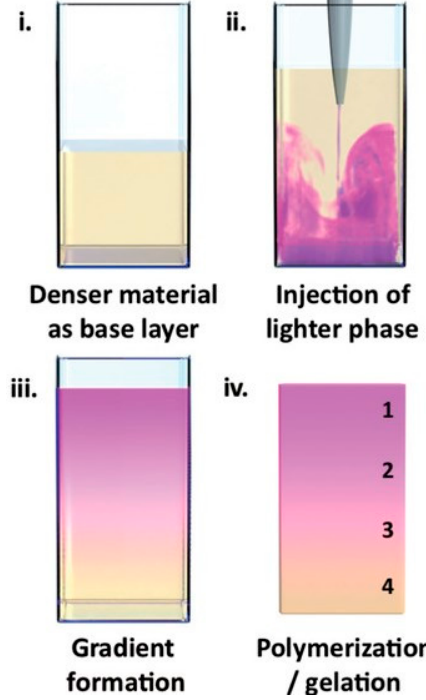
Figure 7. Buoyancy-driven gradient casting. Schematic showing the steps of gradient formation: ( i ) an ase layer (yellow) is added to a mold, ( ii ) the injection phase (purple) is introduced during a single injection at a controlled rate, ( iii ) the system is allowed to equilibrate and form a material gradient, and ( iv ) the gradient is preserved by gelling or polymerizing the material. Reprinted from [24] with permission. Polymers 2020 , 12 , x